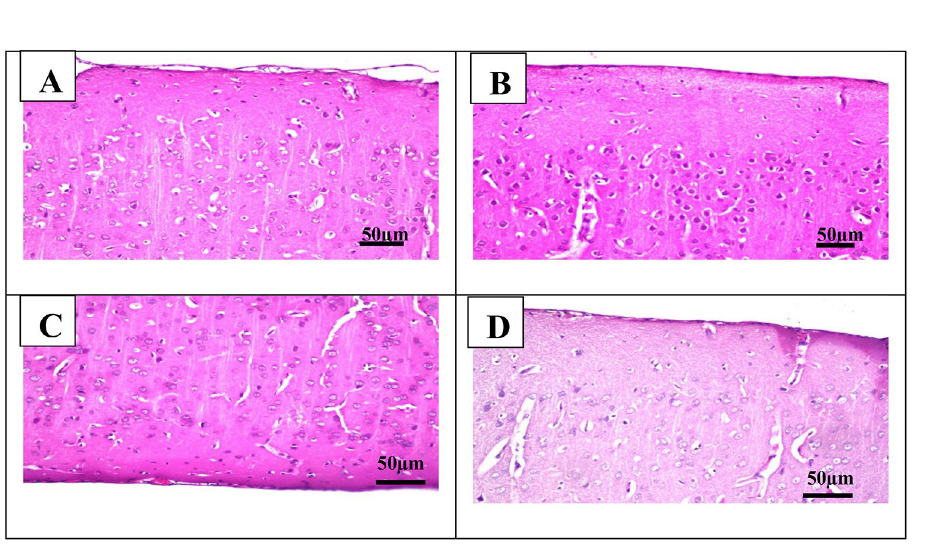
Figure 7. Representative photomicrographs (H&E, × 200) of the cerebral cortex (A) control group, (B) Cyclophosphamide group, (C) Lutein 50 group, and ( D) Lutein 100